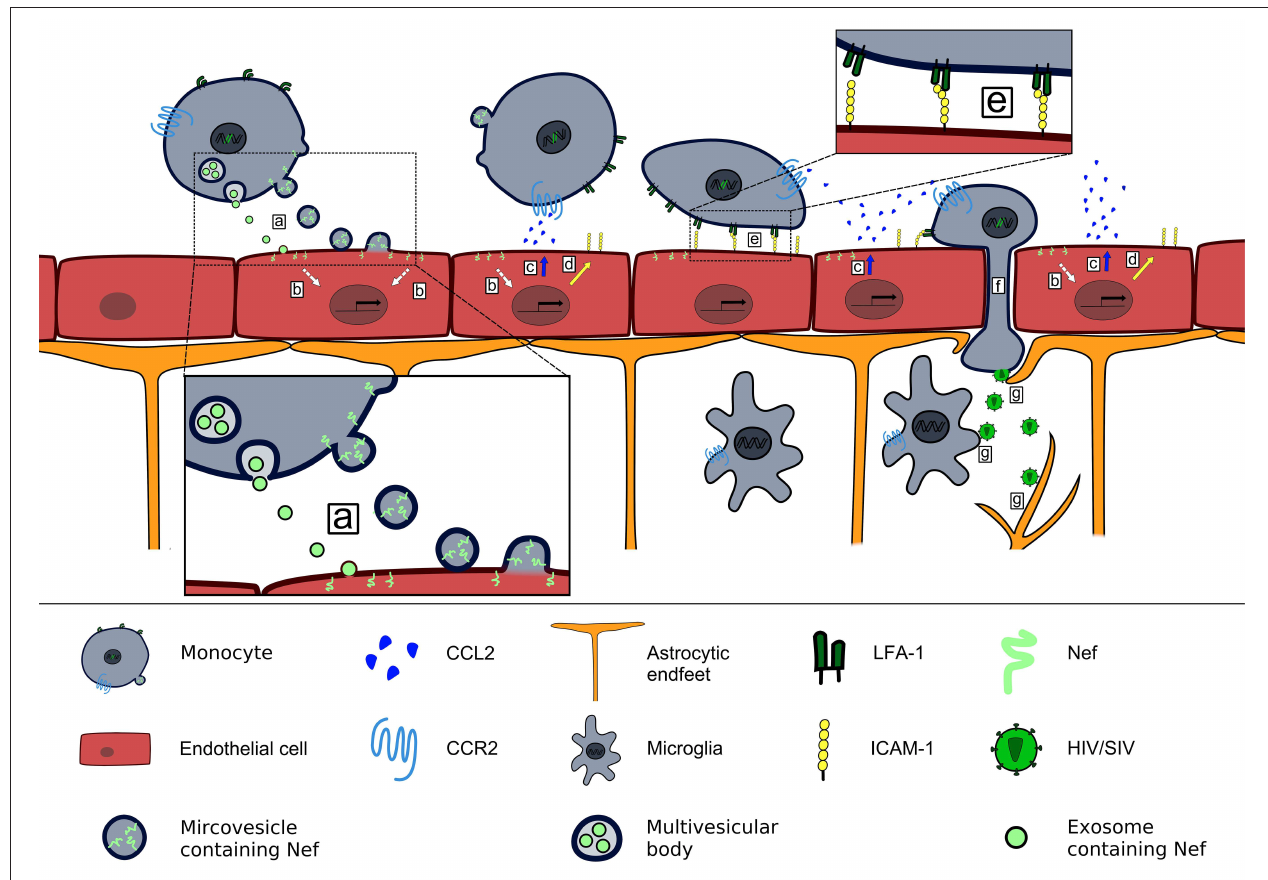
FIGURE 1 | Contribution of Nef-induced CCL2 expression to HIV/SIV neurotropism. HIV/SIV infected monocytes release microvesicles and exosomes that transfer Nef into brain endothelial cells (a), where Nef induces a signaling pathway (b) that leads to release of CCL2 at the luminal side of the BBB (c) and upregulation of ICAM-1 (d). CCL2 binding to CCR2 + cells triggers a conformational change of LFA-1 that enables their firm adhesion to brain endothelial cells via LFA-1–ICAM-1 interaction (e). Endothelial CCL2 expression enables transendothelial migration of HIV/SIV-infected CCR2 + monocytes into the brain parenchyma (101) (f). There HIV/SIV infects astrocytes and microglia